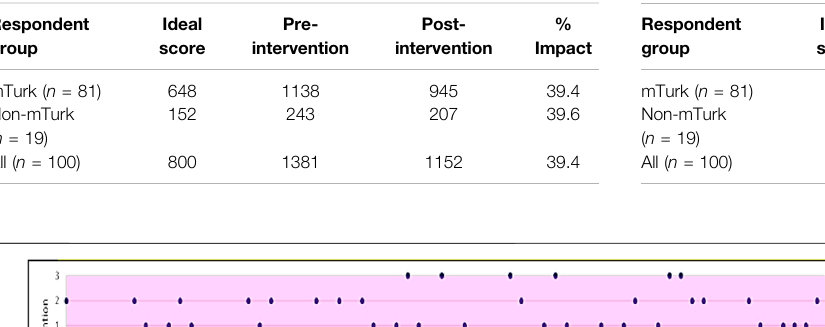
TABLE 3 | Percentage impact of the intervention on Necessity beliefs.